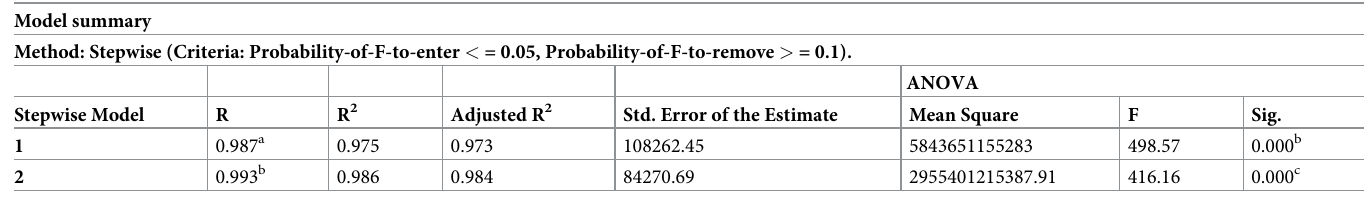
Table 1. Stepwise regression for the relationships between socio-economic factors (general government expenditure, unemployment rate, per capital income, GDP per capita (PPP constant 2011 international $), and GDP at market price), and total enrollment in Pakistan during 2001–02 to 2015–16. Model